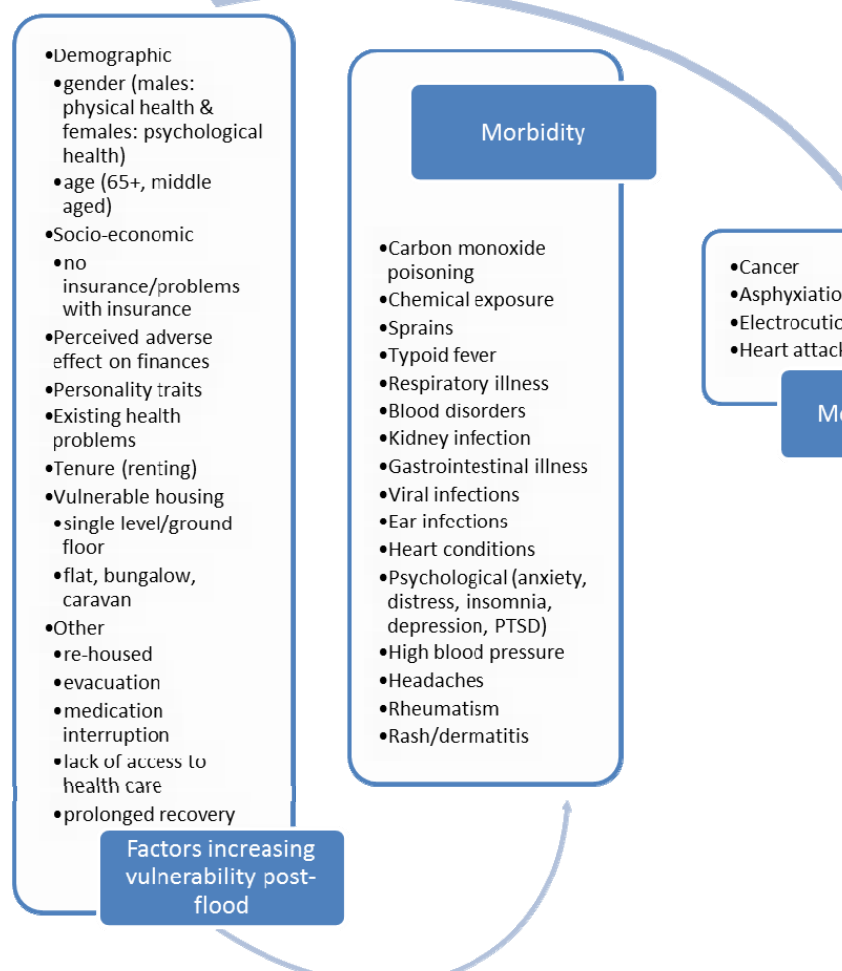
Figure 6. Factors increasing vulnerability to health effects post-flood